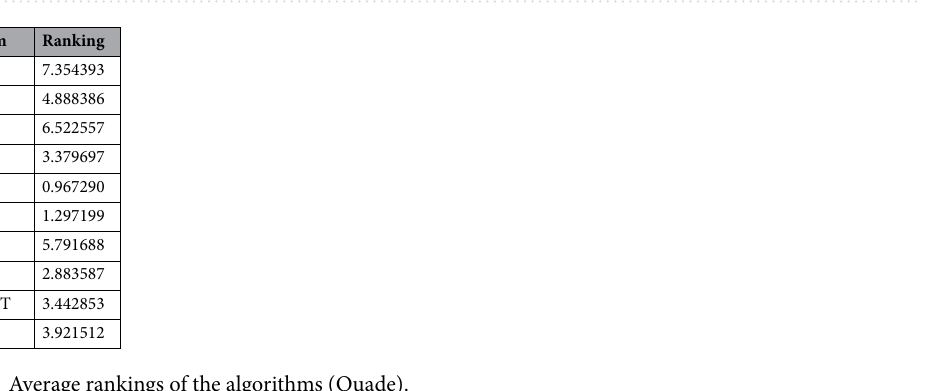
Figure 4. Average reliability and sharpness of the different models across all horizons. The dim blue lines correspond to the different horizons.